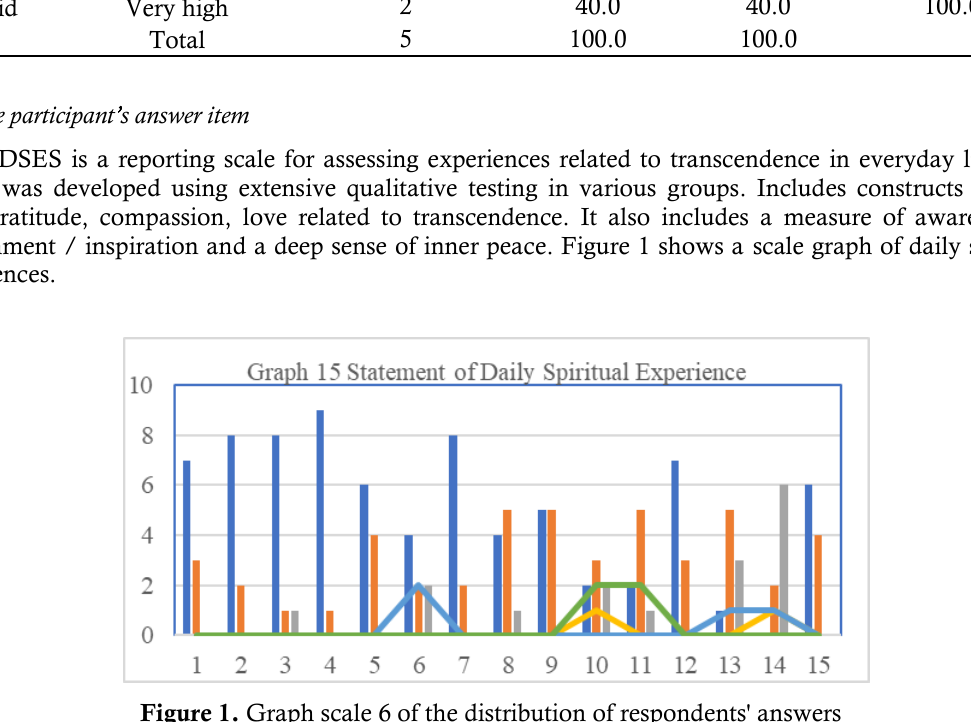
Figure 1. Graph scale 6 of the distribution of respondents'